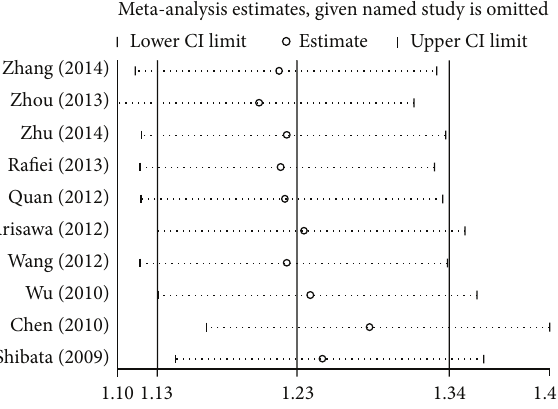
limitMeta-analysis estimates, given named study is omitted